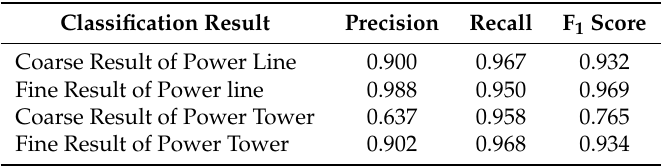
Table 3. Classification accuracy statistics of power facilities.